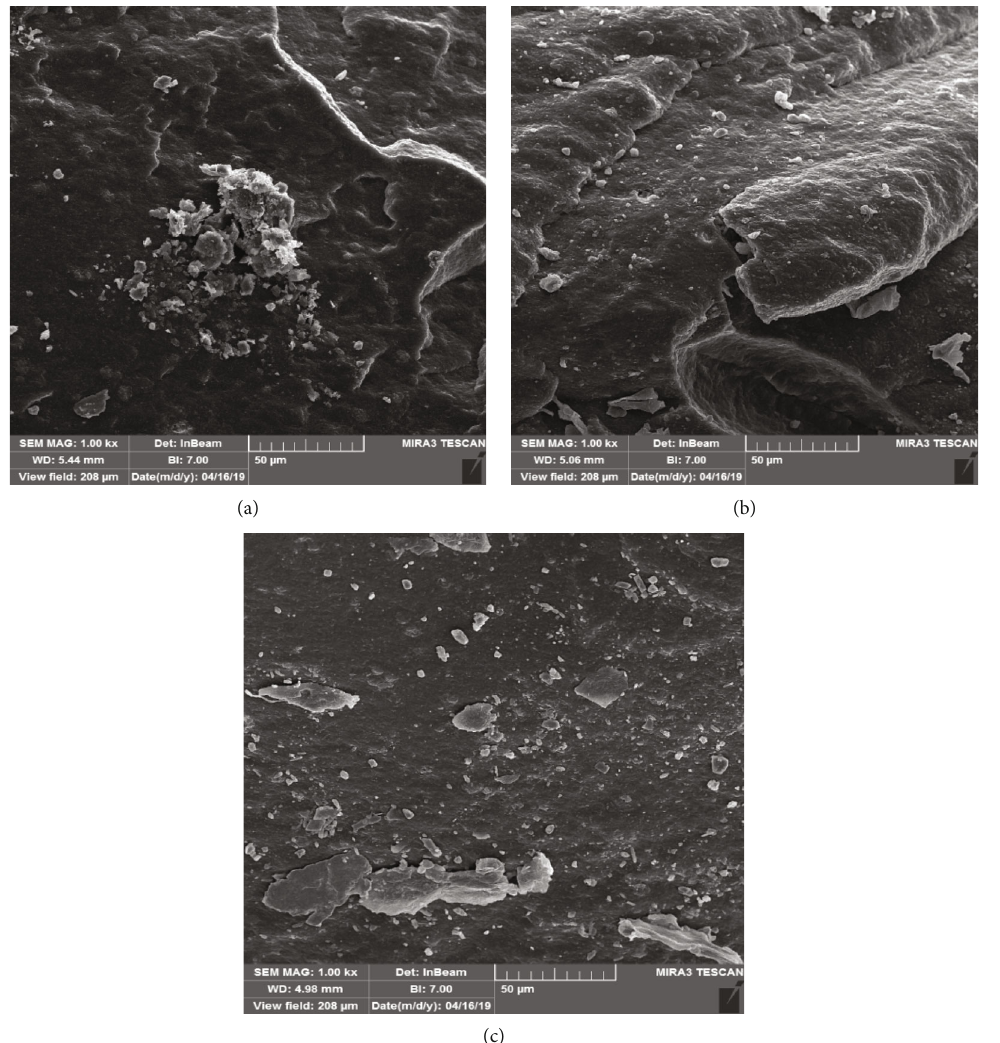
Figure 13: SEM image: (a) 50% strain amplitude for S70N30 sample, (b) 60% strain amplitude for S50N50C5 sample, and (c) 70% strain amplitude for S50N50C5